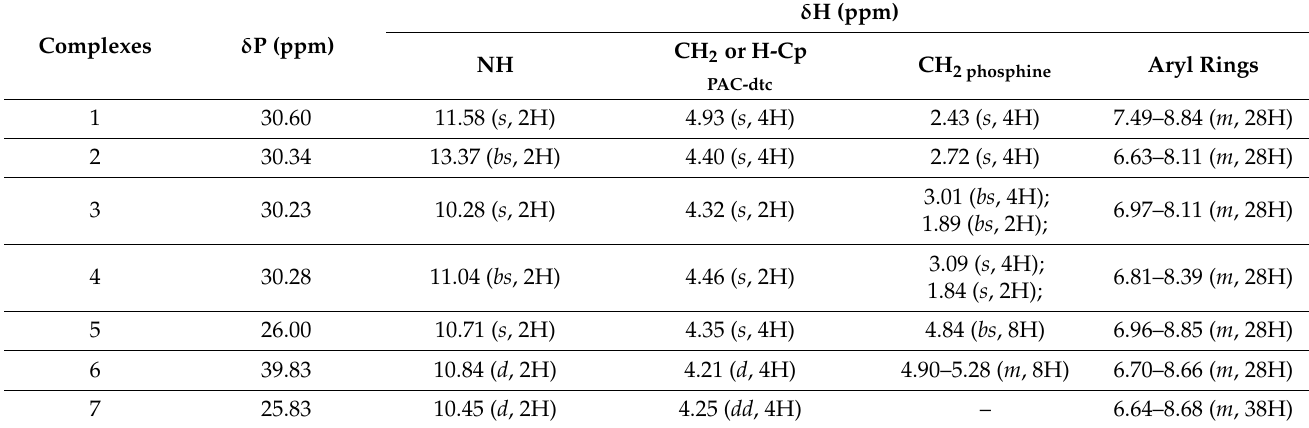
Table 2. 31 P and 1 H nmr chemical shifts of the synthesized complexes.